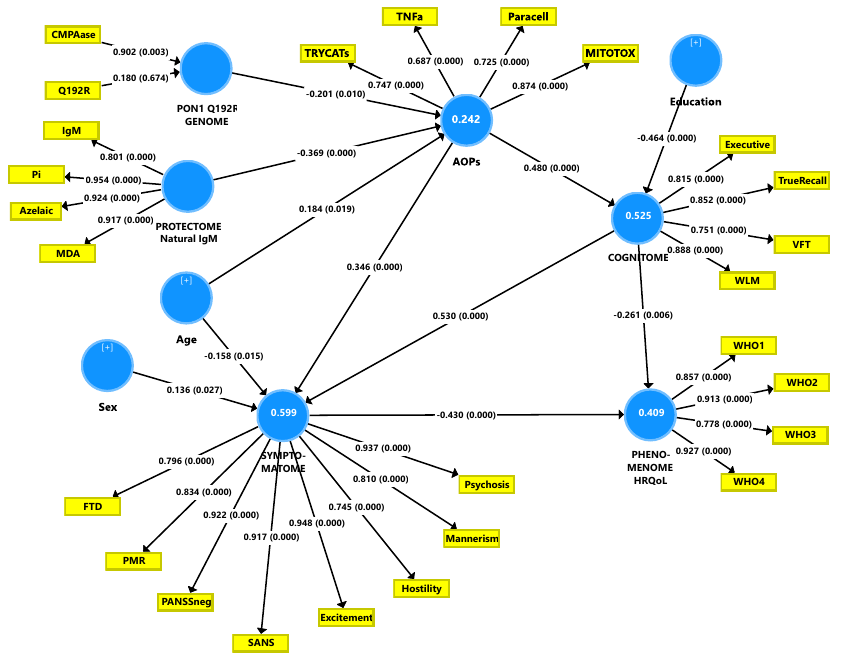
Figure 2. The first Partial Least Squares (PLS) path model constructed in this study.PON1 Q192R: paraoxonase 1 (PON1) genotypes combined with PON1 4(chloromethyl)phenyl acetate (CMPA)ase activity.MDA: malondialdehyde; Pi: phosphatidylinositol; AOPs: adverse outcome pathways; MITOTOX: index of multiple immune and oxidative toxicity; TNF: tumor necrosis factor; Paracell: index of paracellular route breakdown; TRYCATs: IgA to tryptophan catabolites; SANS: the Scale for the Assessment of Negative Symptoms; PANSSneg: the negative subscale of the Positive and Negative Syndrome Scale; FTD: formal thought disorders; PMR: psychomotor retardation. HRQoL: health-related quality of life; WHO 1-4: World Health Organization Quality of Life Instrument domains (domains 1-4). The white figures in blue circles indicate the explained